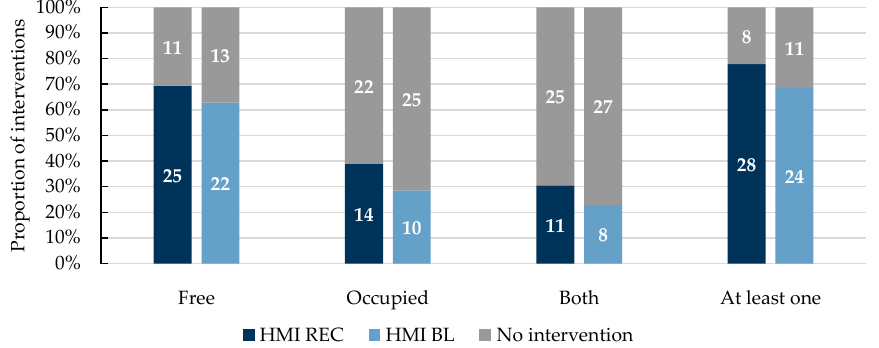
Figure 4. Number of interventions.